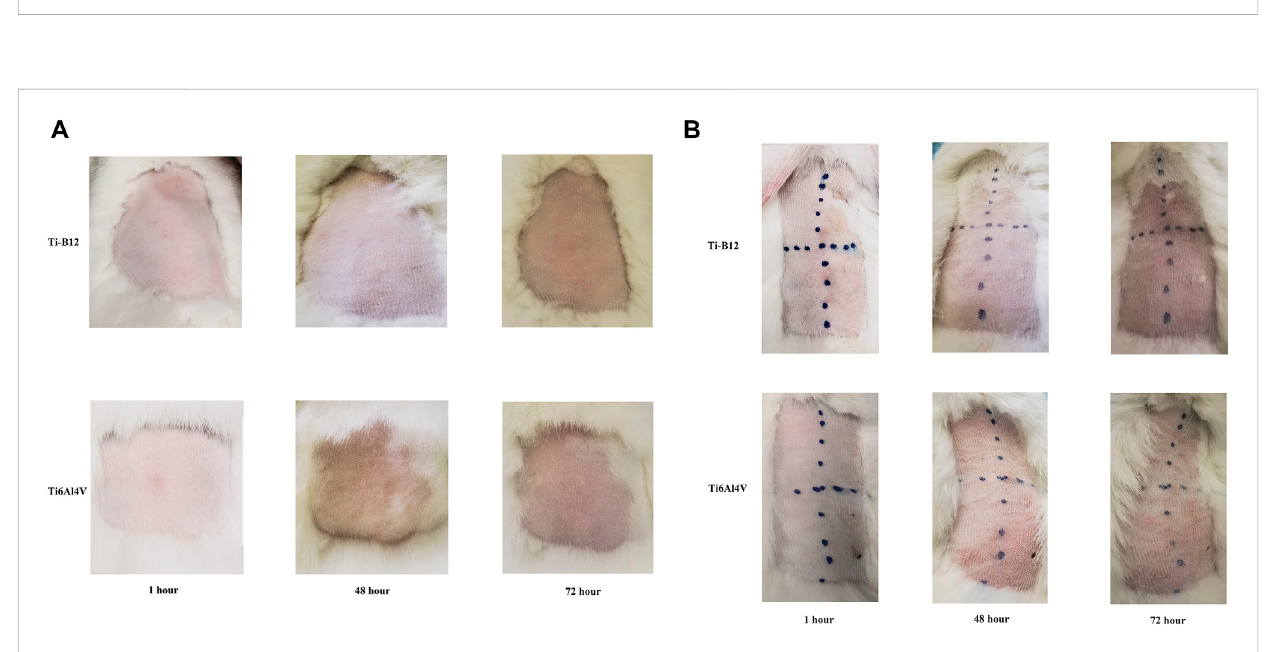
FIGURE 5 (A) skin irritation test. (B) intradermal stimulation